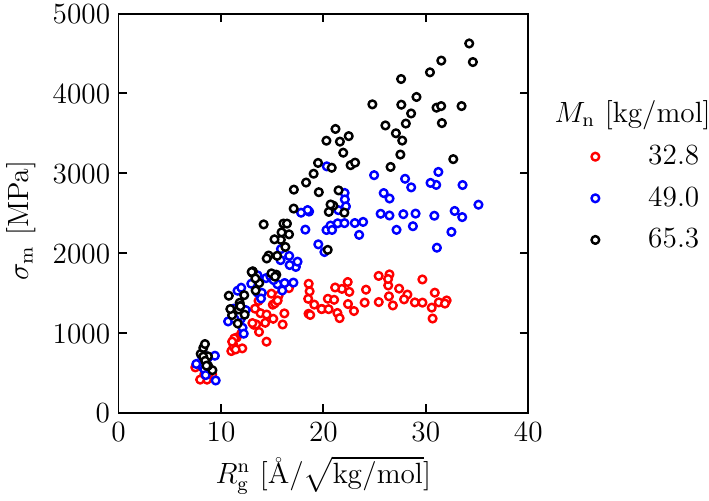
Figure 13. σ m as a function of normalized radius of gyration ( R n g ) for different M n . Molecular weight is proportional to the number of entanglements per molecule. The molecular chain of high M n has a long contour length and a higher chance of